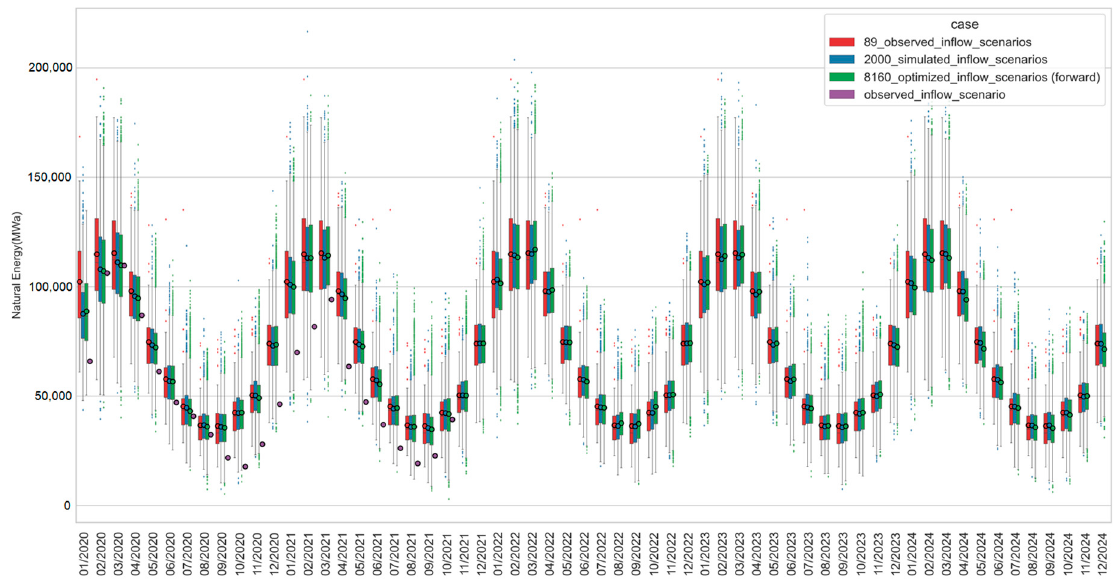
Figure 11. This figure shows the historical inflow realizations (red), the 2000 inflow series used in the simulation step (blue), the 8160 scenarios used at the optimization (green), and the observed inflow scenario from January 2020 to October